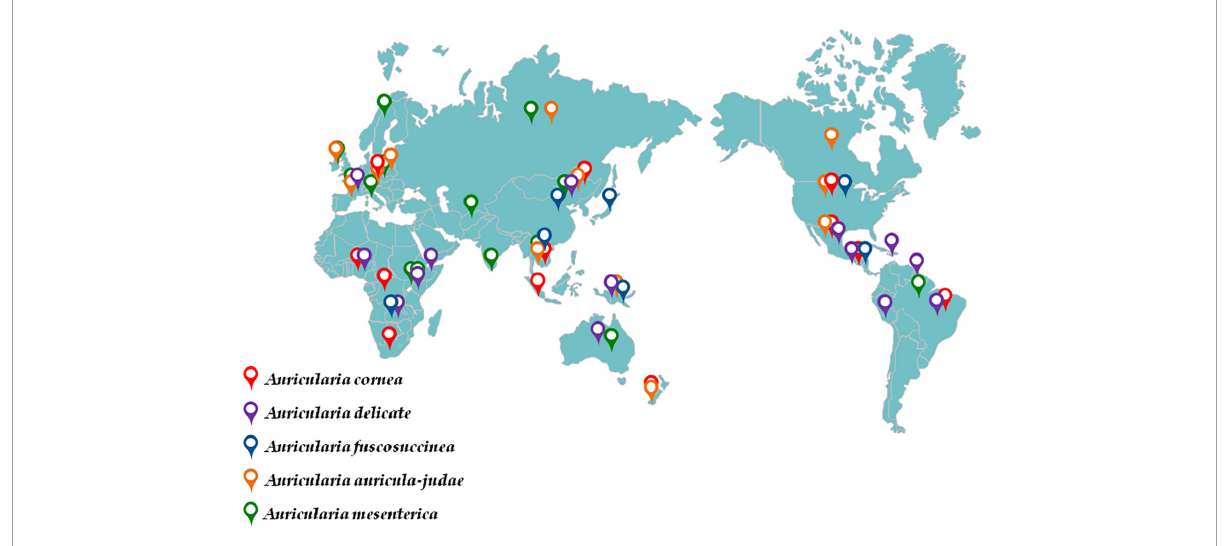
FIGURE2 Global distribution of Auricularia